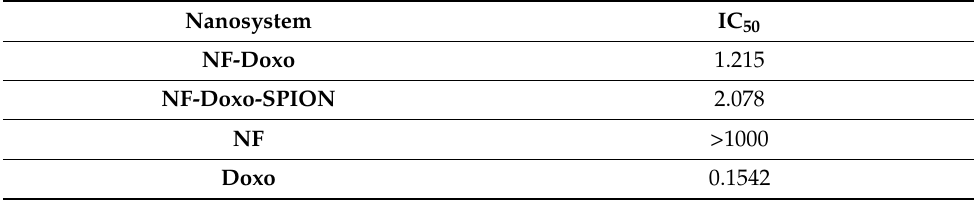
Table 4. IC 50 ( µ M) values on